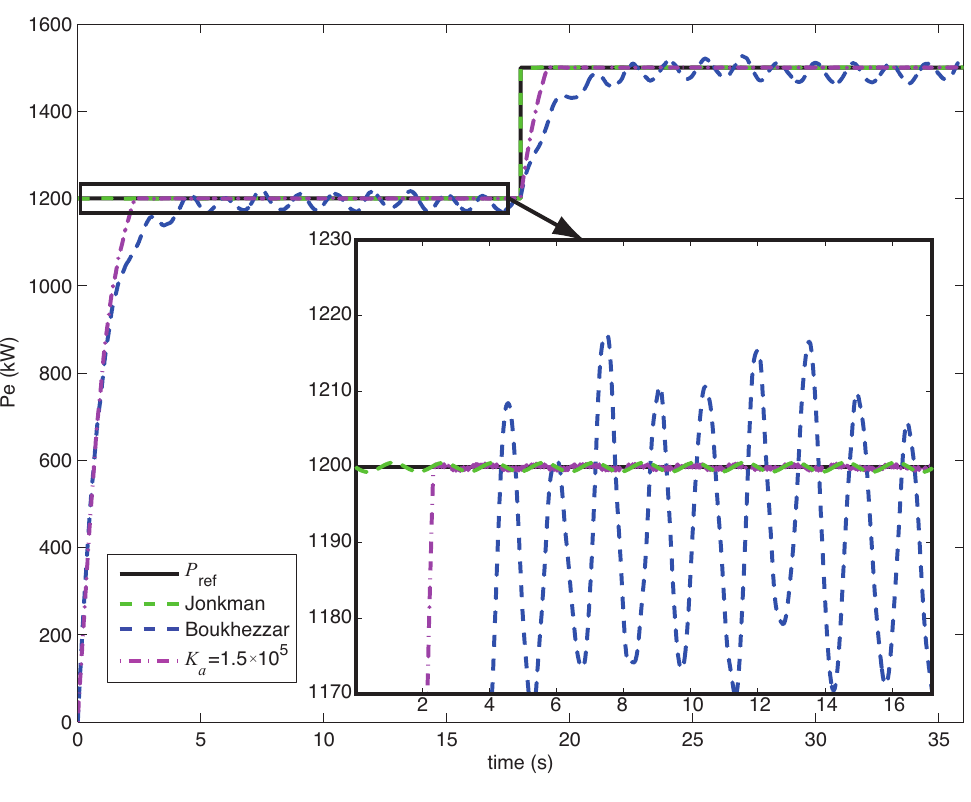
Figure 14. Power output with a periodic noise